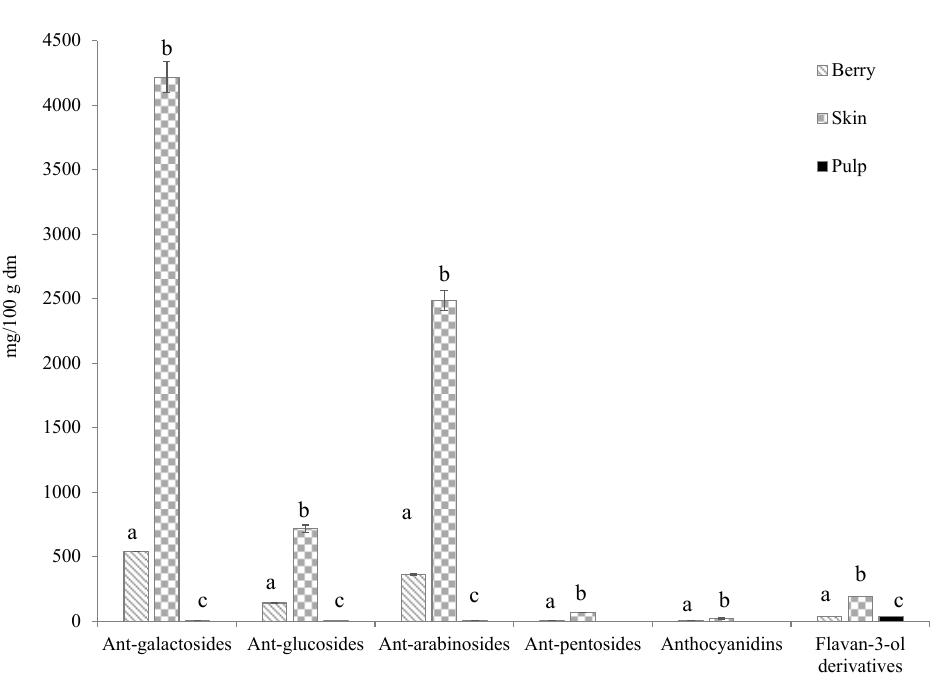
Figure 1. Concentrations (mg/100 g d.m.) of 3-monogalactosides, 3-monoglucosides, 3-arabinosides and 3-pentosides derivatives of anthocyanins and anthocyanidins and flavan-3-ol derivatives in berries, skin and pulp of Windsor blueberry (means and standard deviations). Values with different superscript letters are significantly different, p = 0.01.